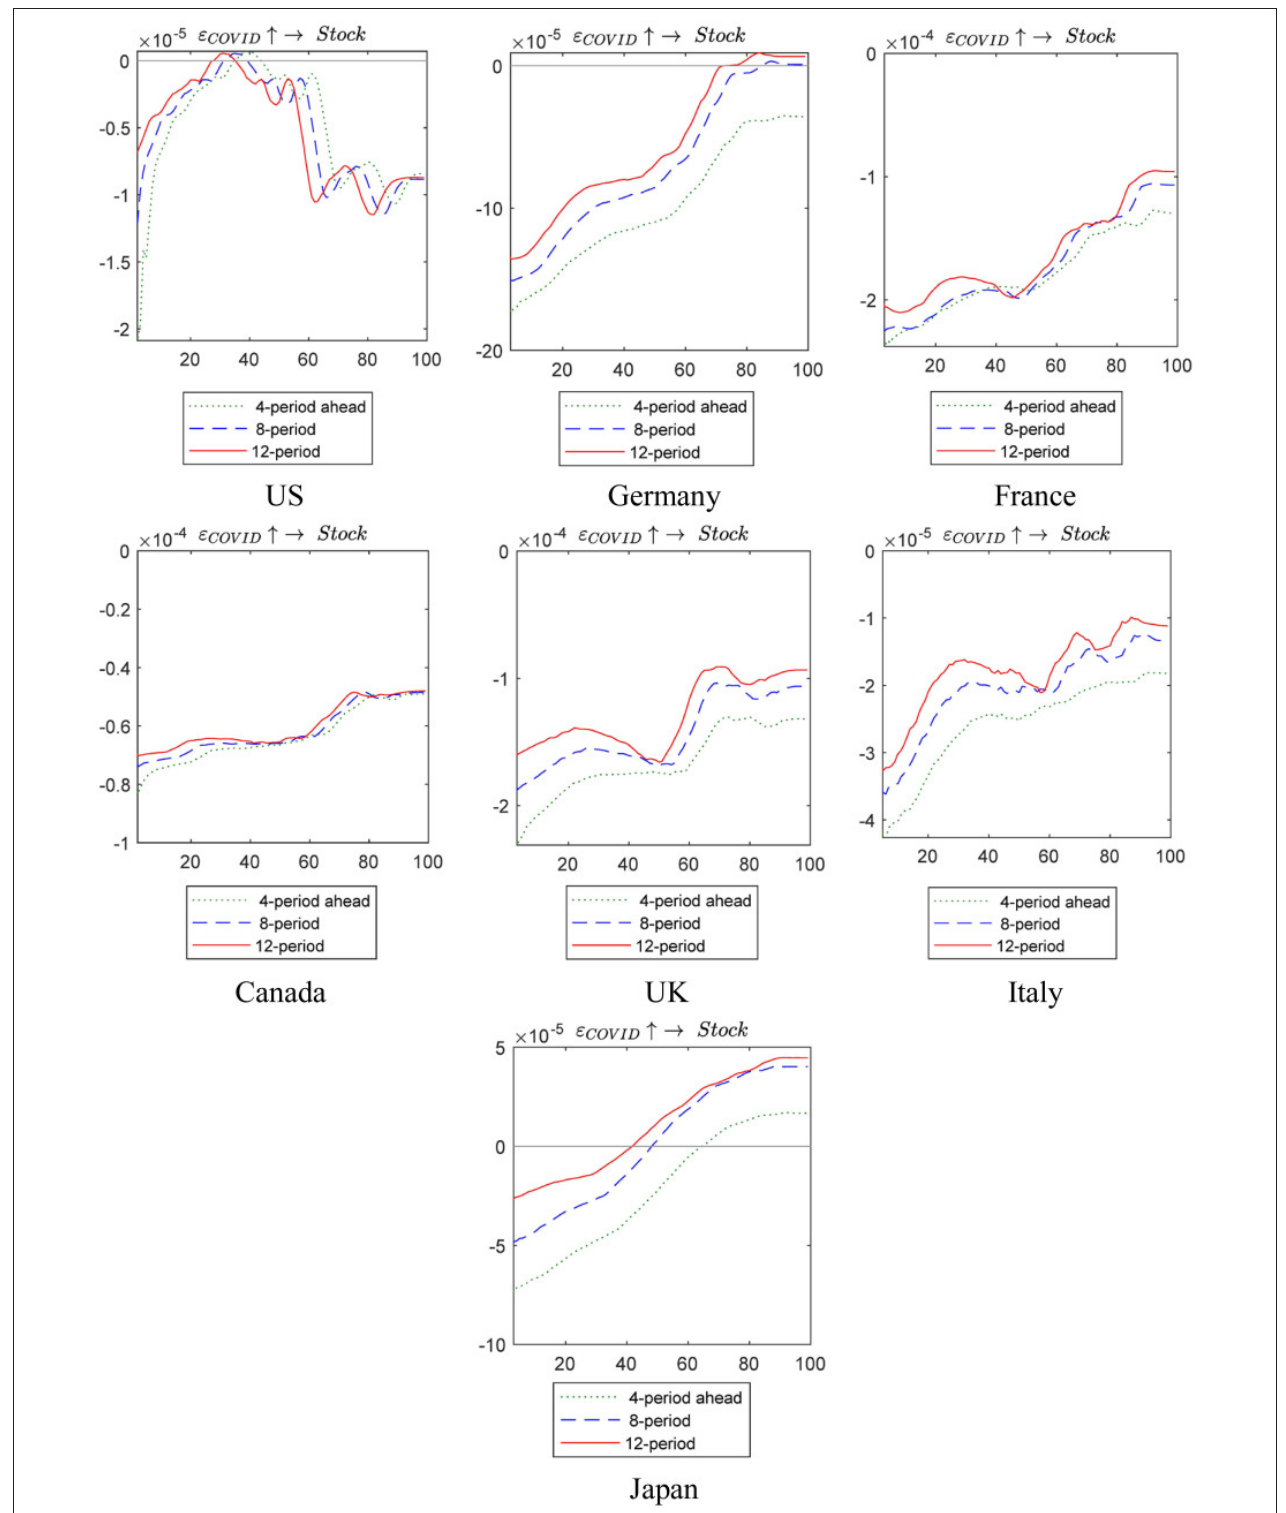
FIGURE 1 | The equal interval impulse response of stock returns to the COVID-19 epidemic.